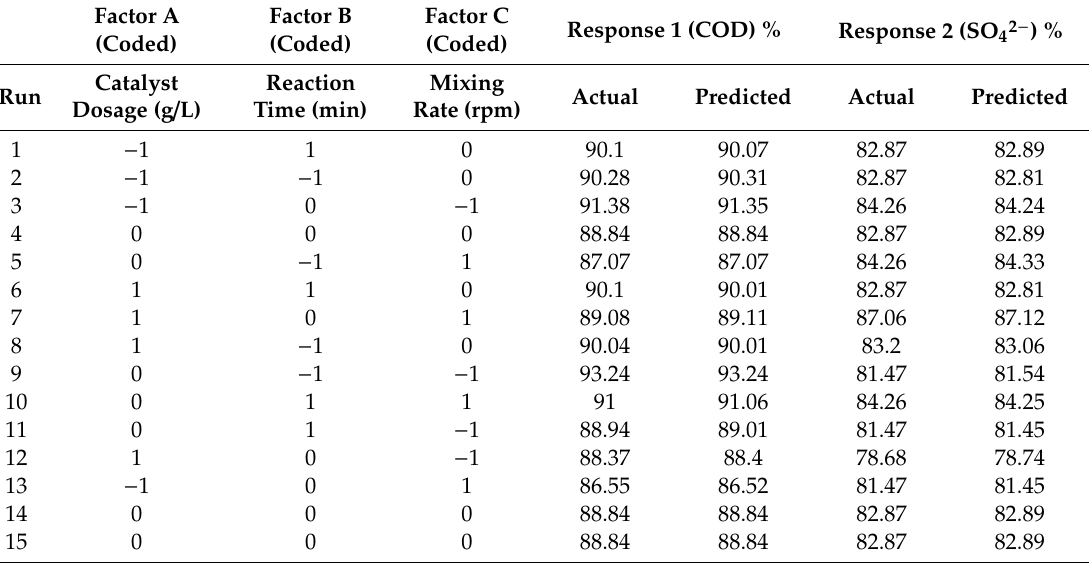
Table 3. Coded matrix and response values for